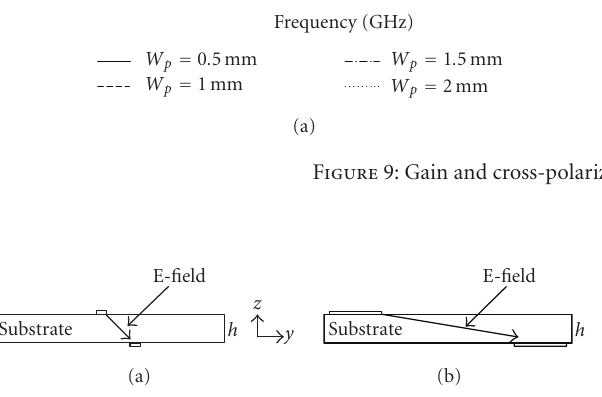
Figure 10: Cross-section view of the DETASA: (a) cross section of the DETASA next to the feeding transition, (b) cross section of the DETASA close to the